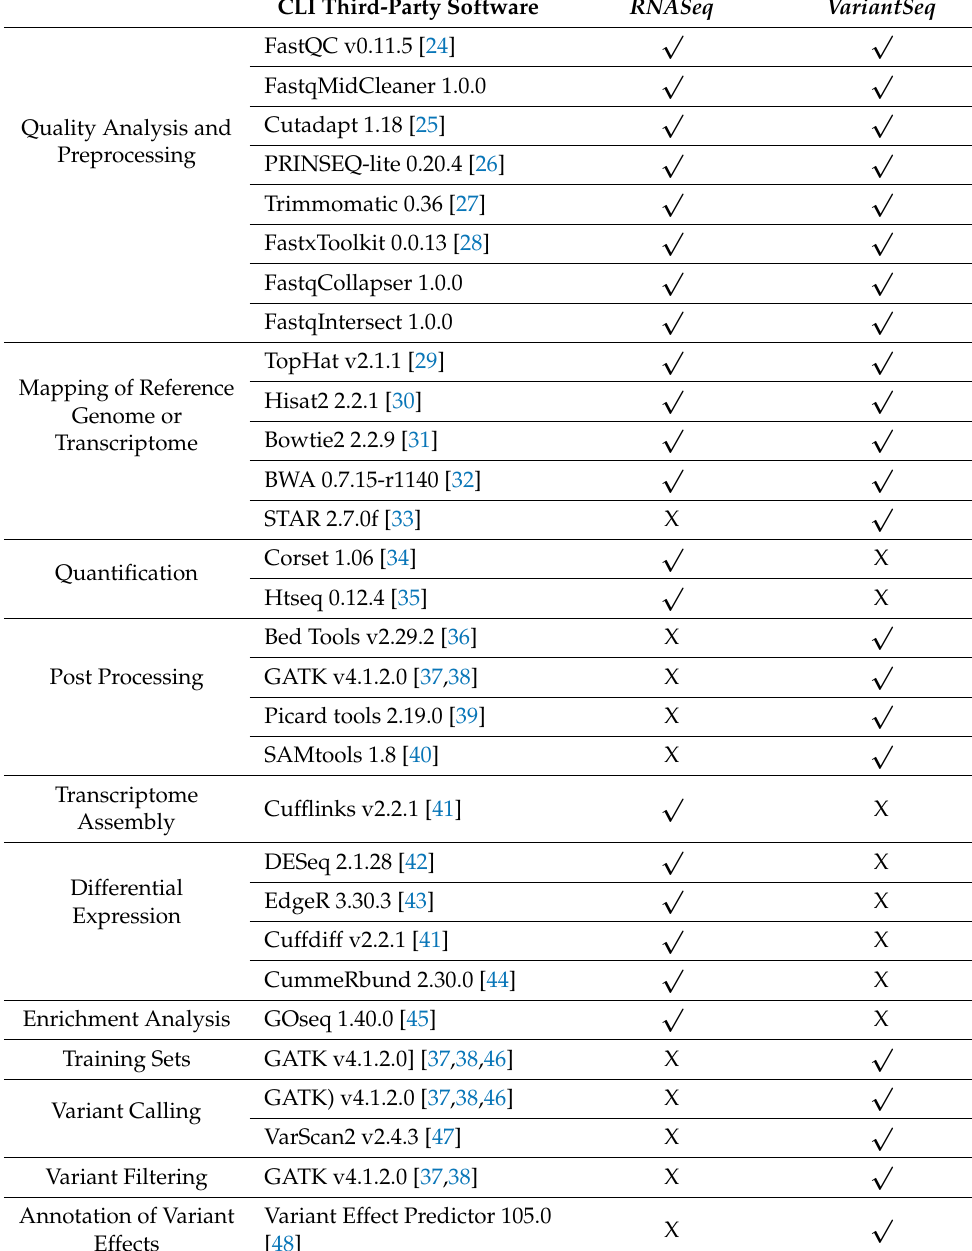
Table 1. CLI software dependencies of “ RNASeq ” and “ VariantSeq ” at the